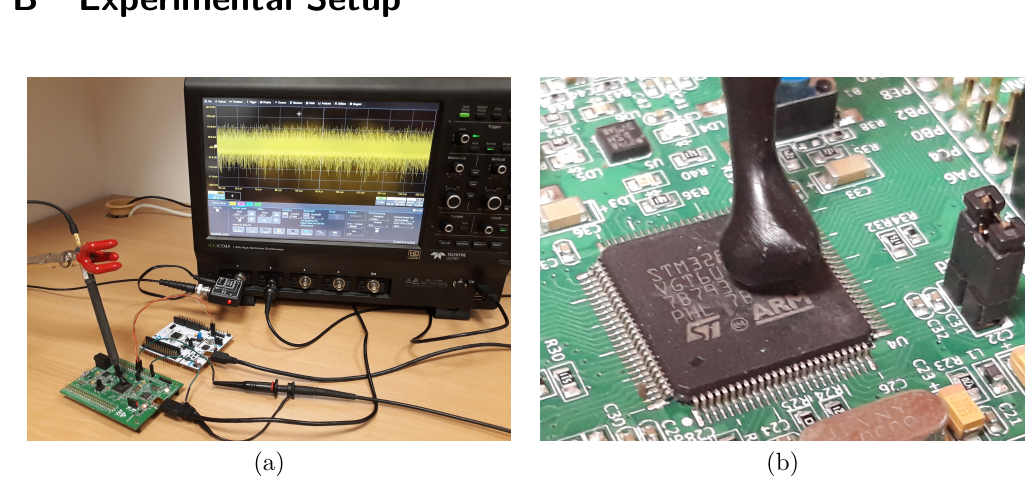
Figure 6: (a) Experimental Setup (b) Zoomed-in view of EM-probe over the DUT